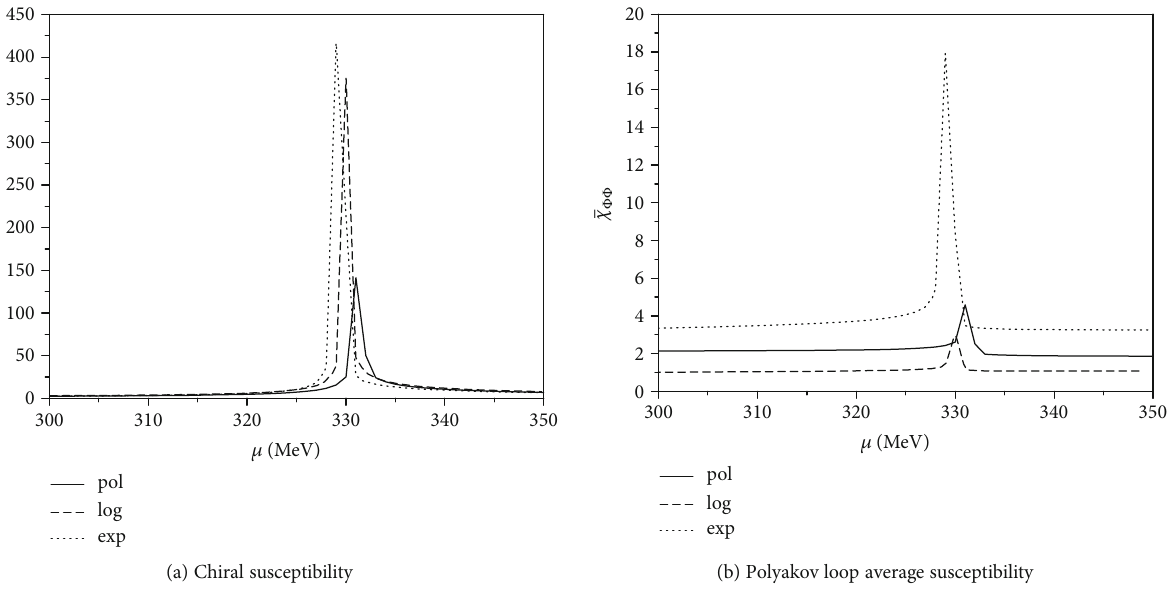
Figure 3: Susceptibilities as a function of chemical potential at CEP temperature.